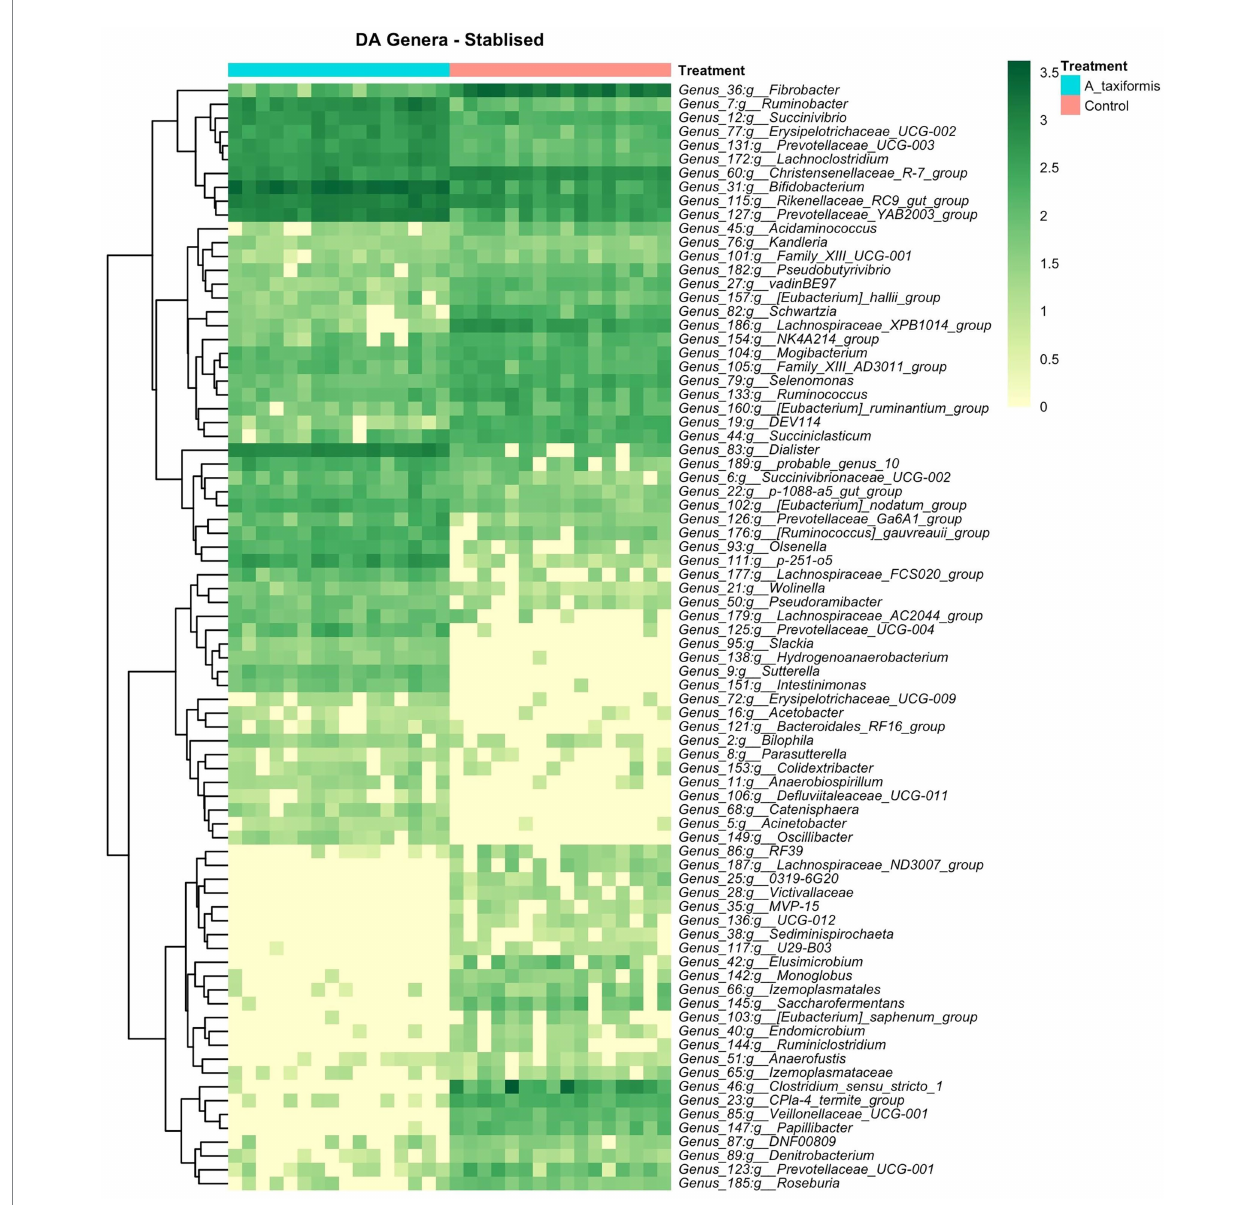
FIGURE 7 Differential abundance (DA) analysis of bacterial genera. Heatmaps of DA genera for the stabilized phase. Raw count data was log transformed for plotting. Genera denoted as uncultured or unknown are